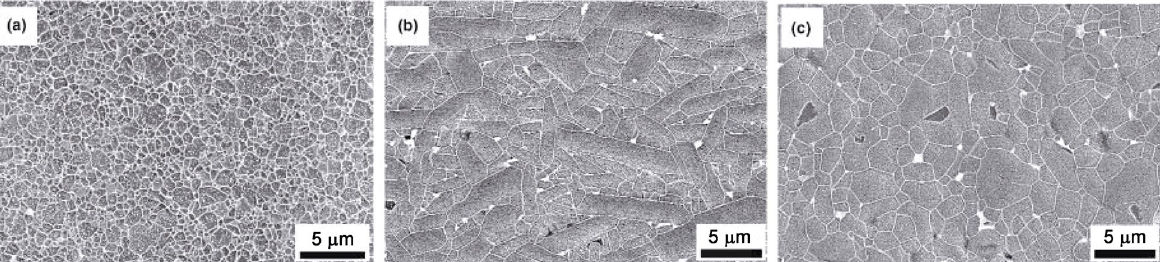
Fig. 38 Surface morphologies of the untextured HPed SiC–YAG specimen and the textured HFed SiC–YAG specimen: (a) HPed specimen surface parallel to the pressure direction; (b, c) HFed specimen surfaces parallel and perpendicular to the pressure direction, respectively. Reproduced with permission from Ref. [279], © Acta Materialia Inc.